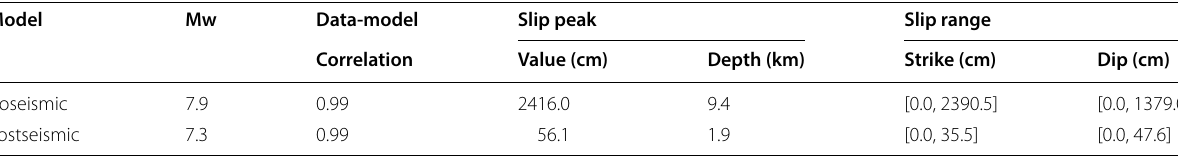
Table 1 Coseismic and postseismic inversion results